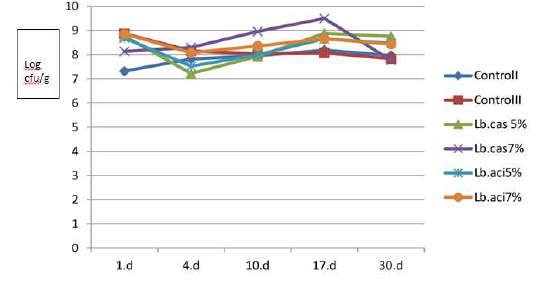
Figure 3. Total lactic acid bacteria (LAB) numbers (log CFU/gr).